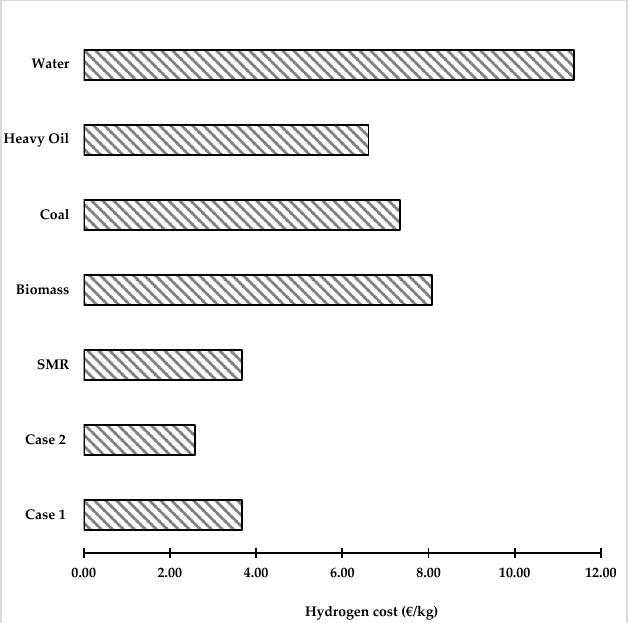
Figure 8. Comparison of hydrogen production costs from waste plastic with those of the literature.